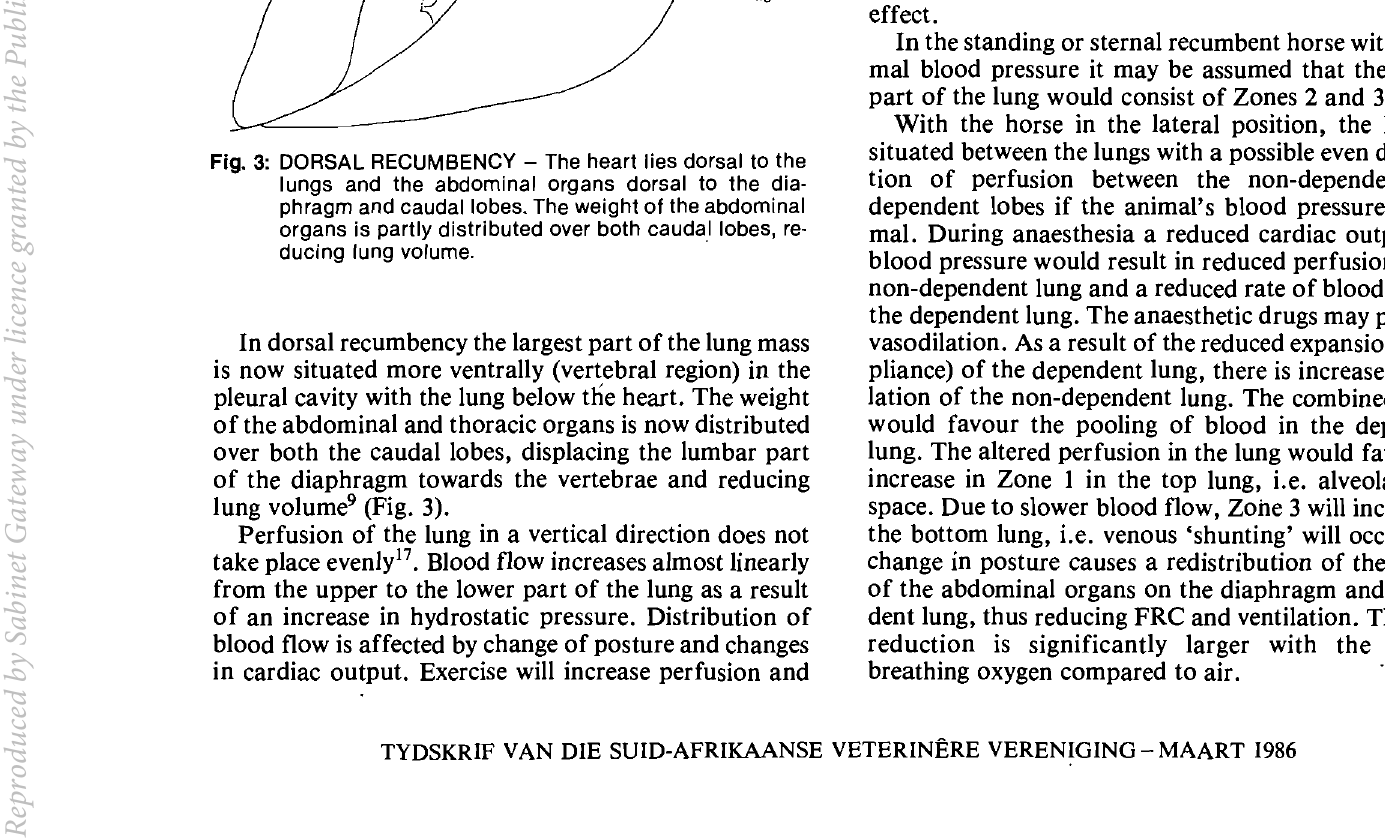
Fig. 4: DIAGRAM illustrating the three zones of blood flow in the lung_ Zone 1, alveolar pressure higher than pulmo nary artery pressure. Zone 2, pulmonary arterial pres sure higher than alveolar pressure. Zone 3, pulmonary arterial pressure higher than pulmonary venous and alveolar pressure. PA = alveolar pressure. Pa =. arterial pressure. Pv = venous pressure.